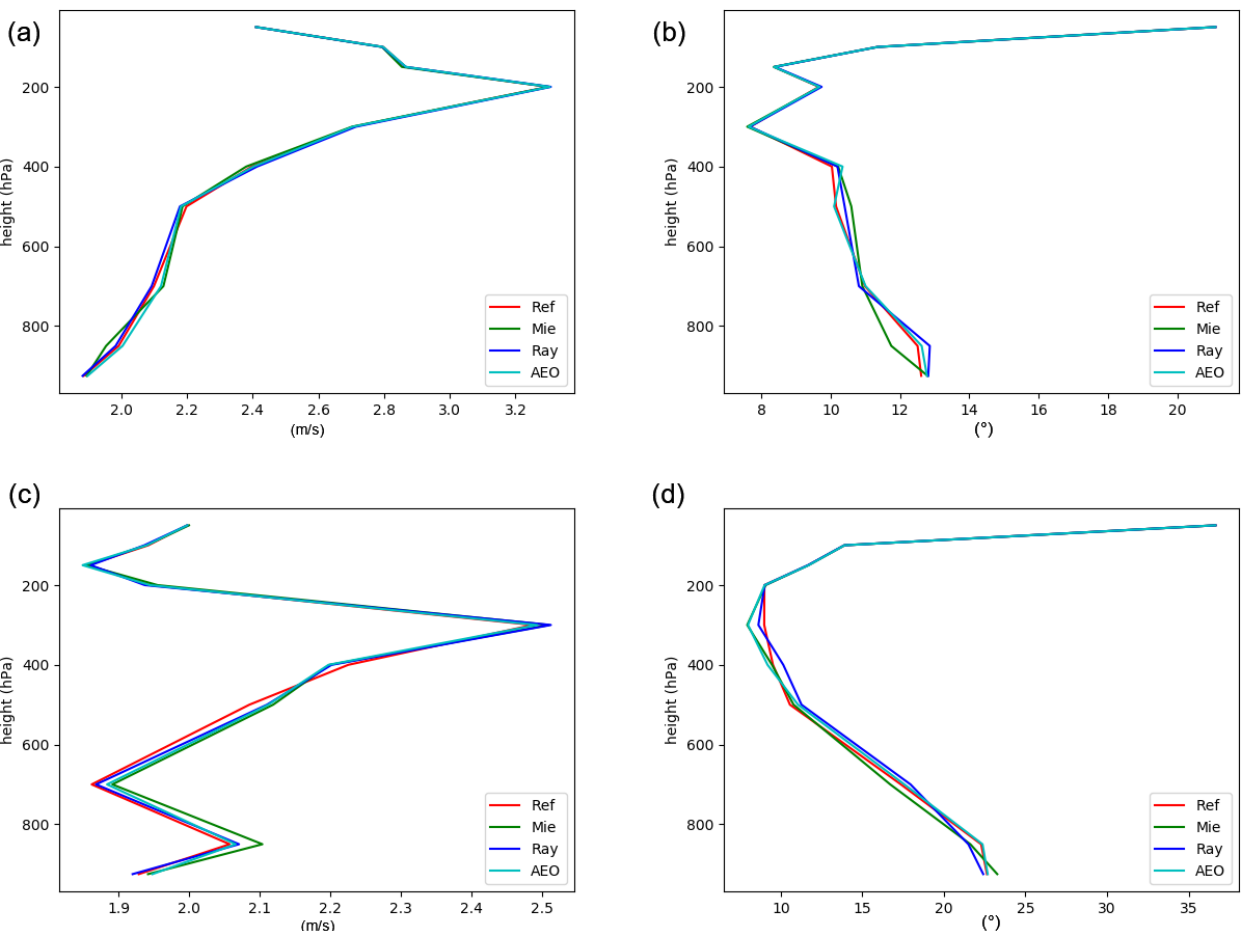
Figure 6. The error standard deviation of the wind speed (a, c) and wind direction (b, d) for the laser A period (a, b) and laser B period (c, d) for the 6h forecast valid at 00:00 and 12:00UTC. The experiment without Aeolus data is shown in red, the Mie only in green, the Rayleigh only in blue, and the experiment using both Mie and Rayleigh in cyan. Note the different sizes of the x axis.